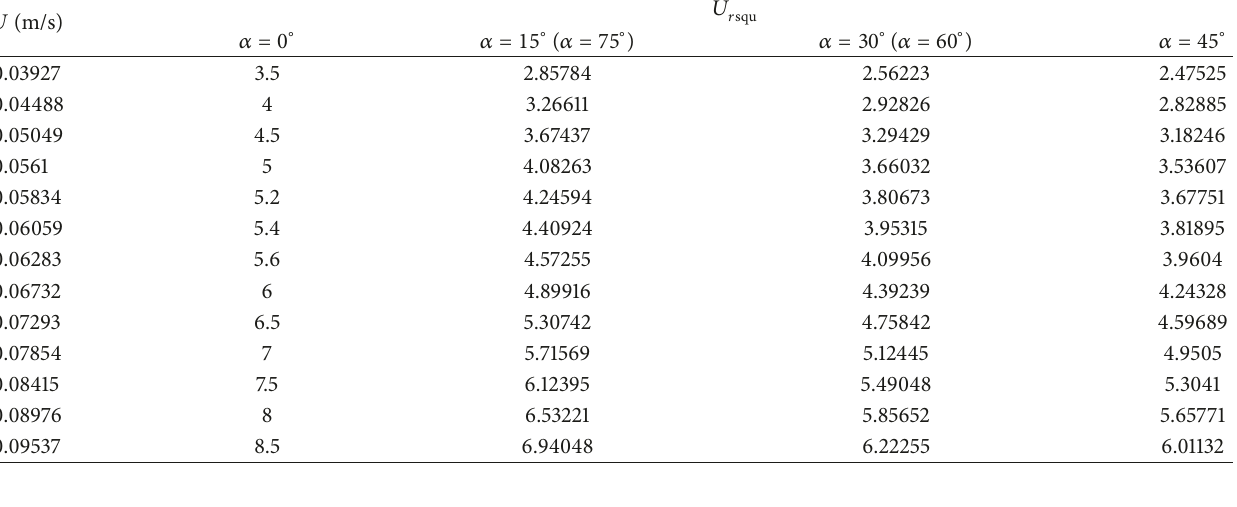
Table 2: Run case of square column in OpenFOAM.